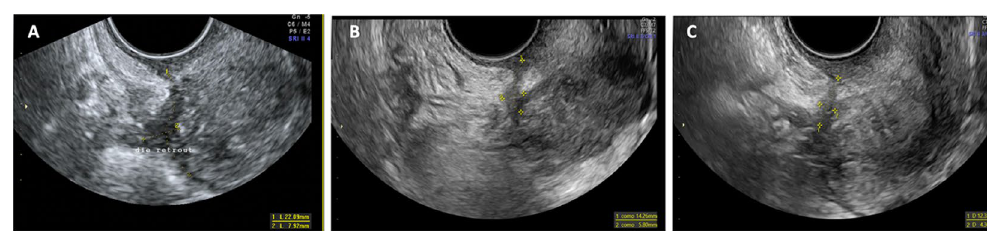
Figure 4. Sonographic evolution of uterosacral deep endometriosis at baseline and at the 12- and 24-month follow-ups. Image ( A ) Uterosacral deep infiltrating nodule with a mean size of 15.0 mm which decreased to 10.0 mm at the 12-month follow-up in image ( B ) and to 8.3 mm at the 24-month follow-up in image ( C